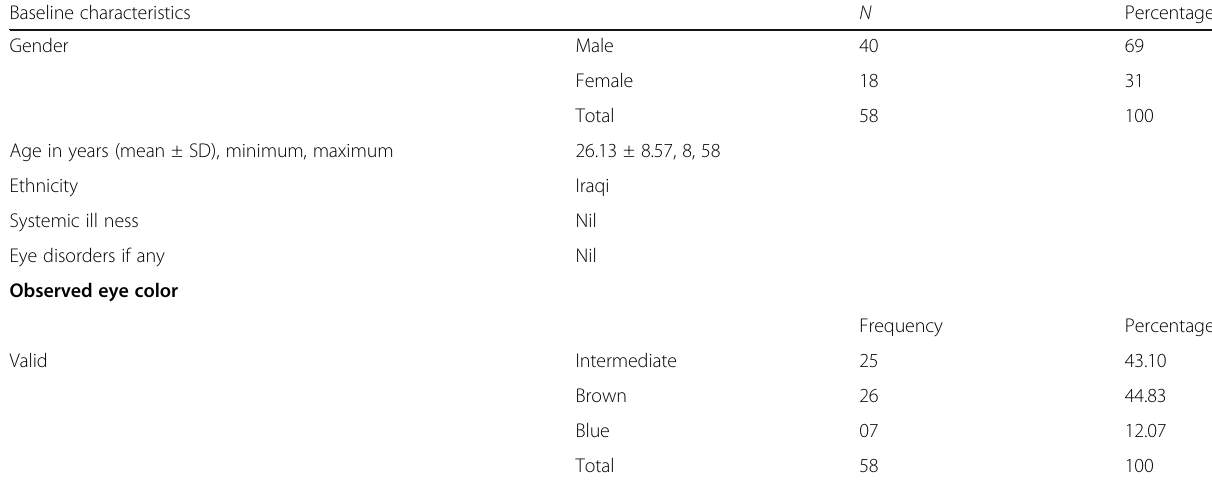
Table 1 Baseline characteristics of participated Iraqi subjects Baseline